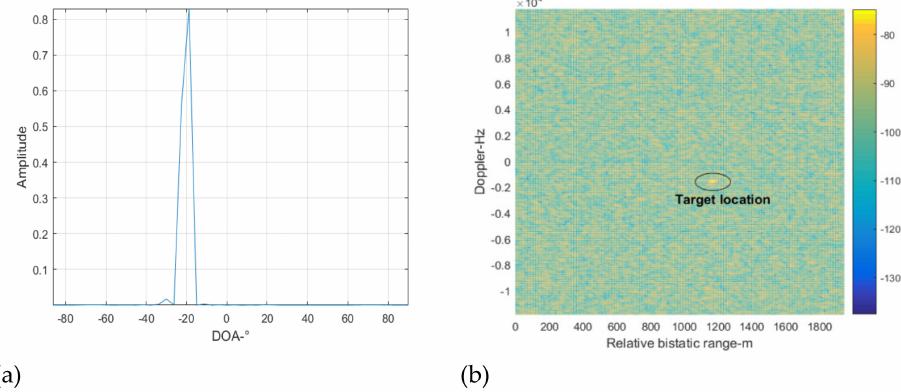
Figure 13. Cross-correlating result at cancellation loop 3, ( a ) spatial spectrum reconstruction results, ( b ) cross-correlation results.